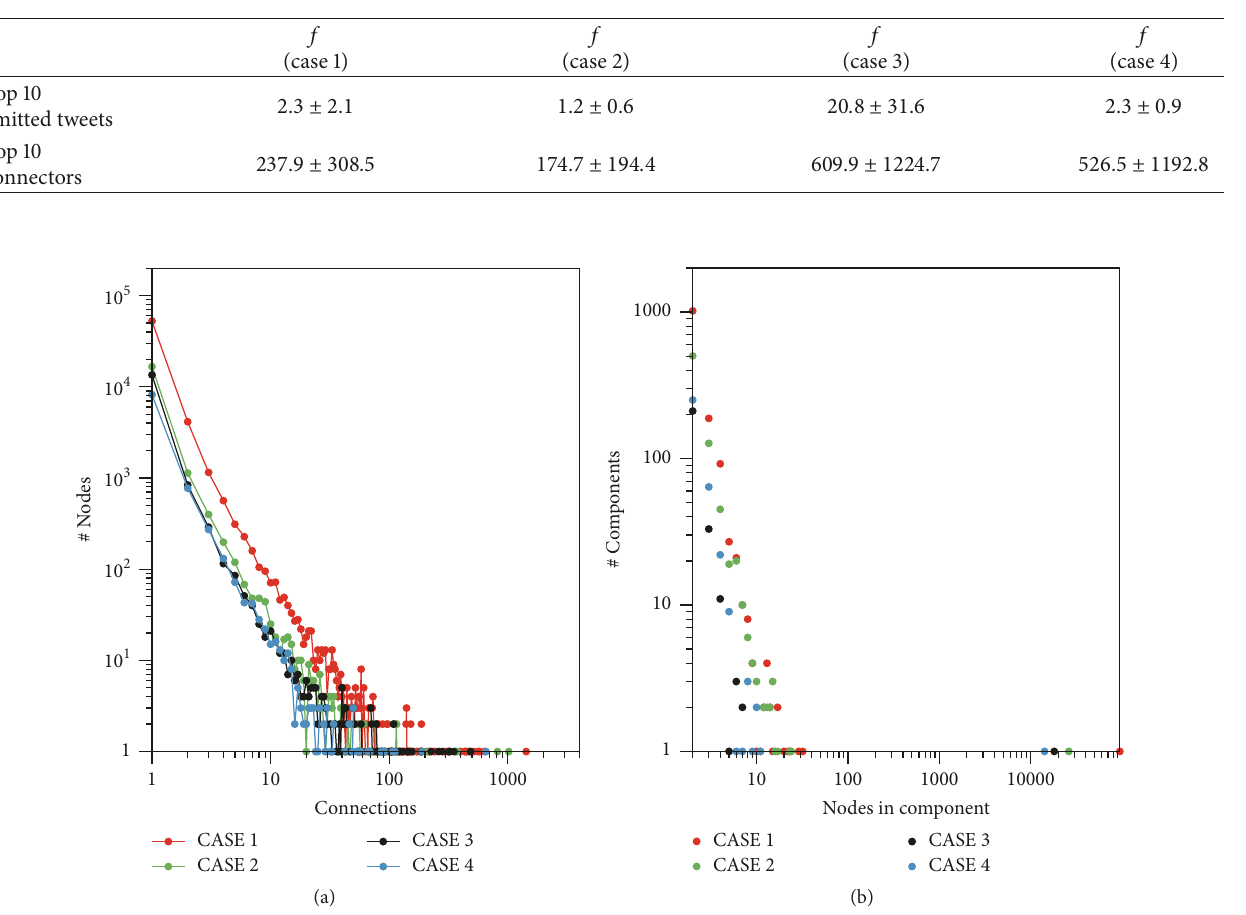
Table 5: Ratio followers/friends (𝑓) for the top 10 users during moments of high activity according to their amount of tweets and links generated.